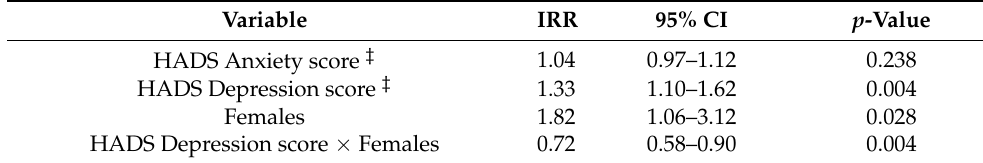
Table 2. Results from negative binomial regression model.